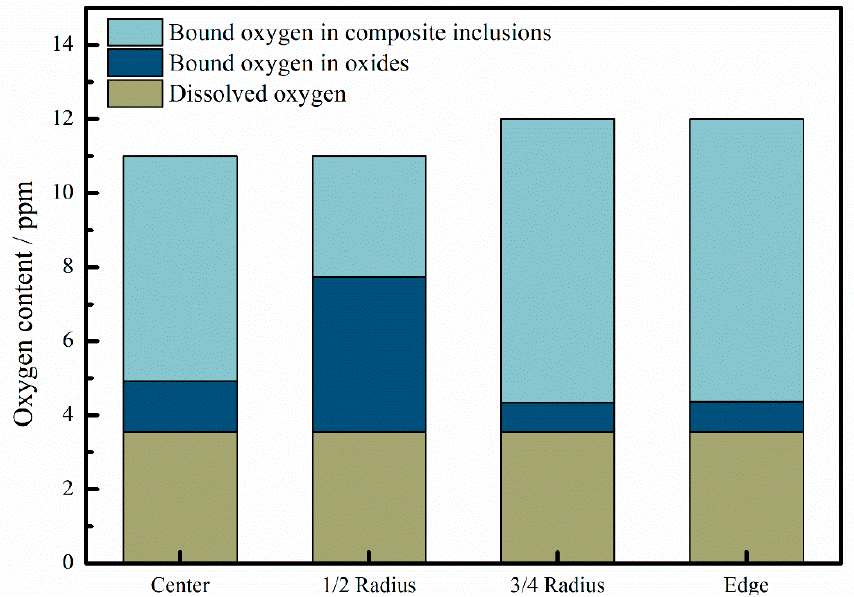
Figure 9. Relationship among dissolved oxygen, bound oxygen in oxides, and bound oxygen in composite inclusions at different locations.